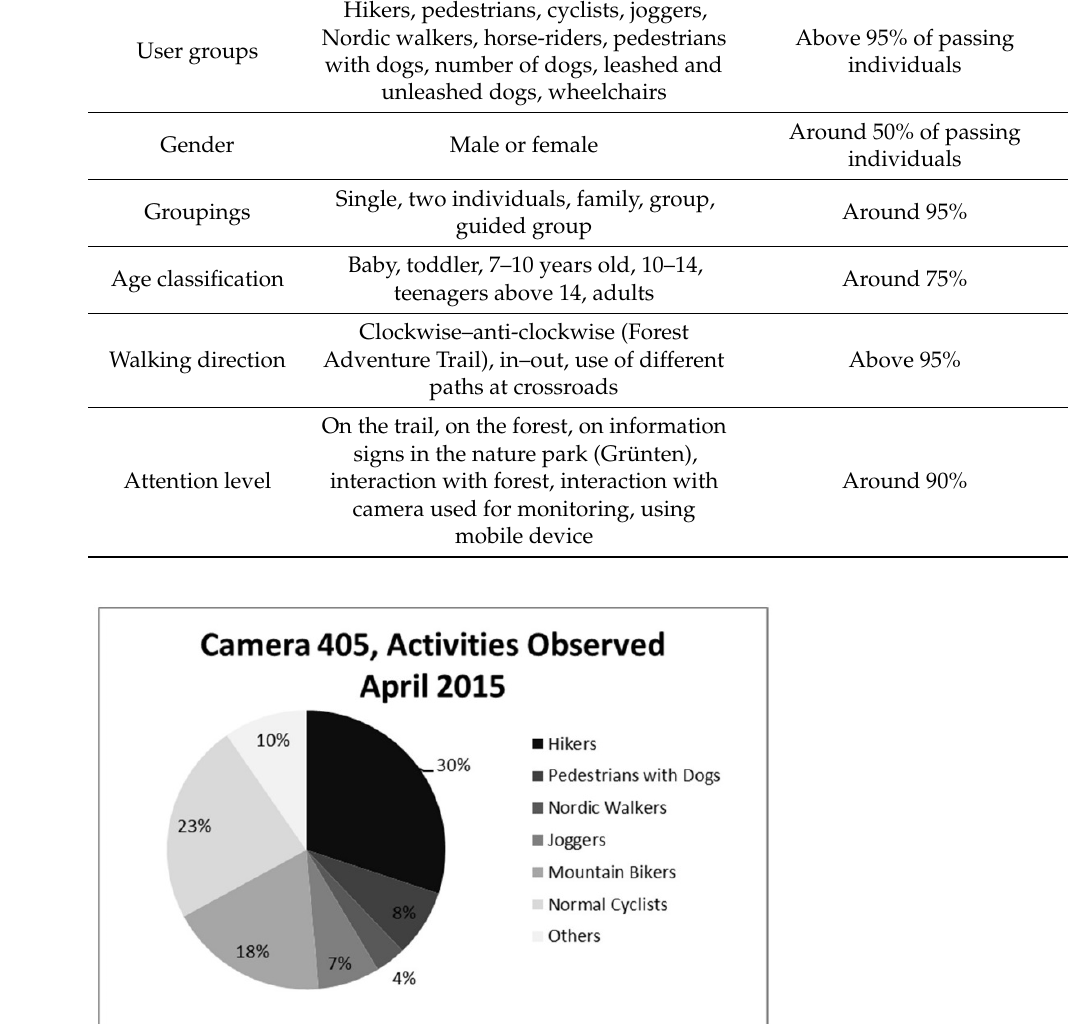
Figure 6. Percentages of attention at the monitoring site “M-Kam/M-Cam” at the Forest Adventure Trail, Freising, Bavaria, Germany, averaged for the period from 19 December 2014, until 6 January 2015; 1804 passersby were counted during this monitoring period. With the metadata from the pictures, including the time and date information, which was automatically assigned to the data when each photo was taken, it was possible to visualize total numbers of passersby per year, per day, or per hour. For management pur- poses, recreational uses on days with rainfall and for different temperature ranges and respective user groups were of interest. For example, “rainy days” with more than 20 mm of rainfall (17 April, 1 May, 5 June, 6 August, 15 August, and 20 November 2015) were extracted and assessed (Figure 7); while there was an average of 111 passersby per day on average at camera 405, on “rainy days”, only 33 individuals were counted. Pedestrians with dogs were regular visitors to the forest and their number only decreased slightly.